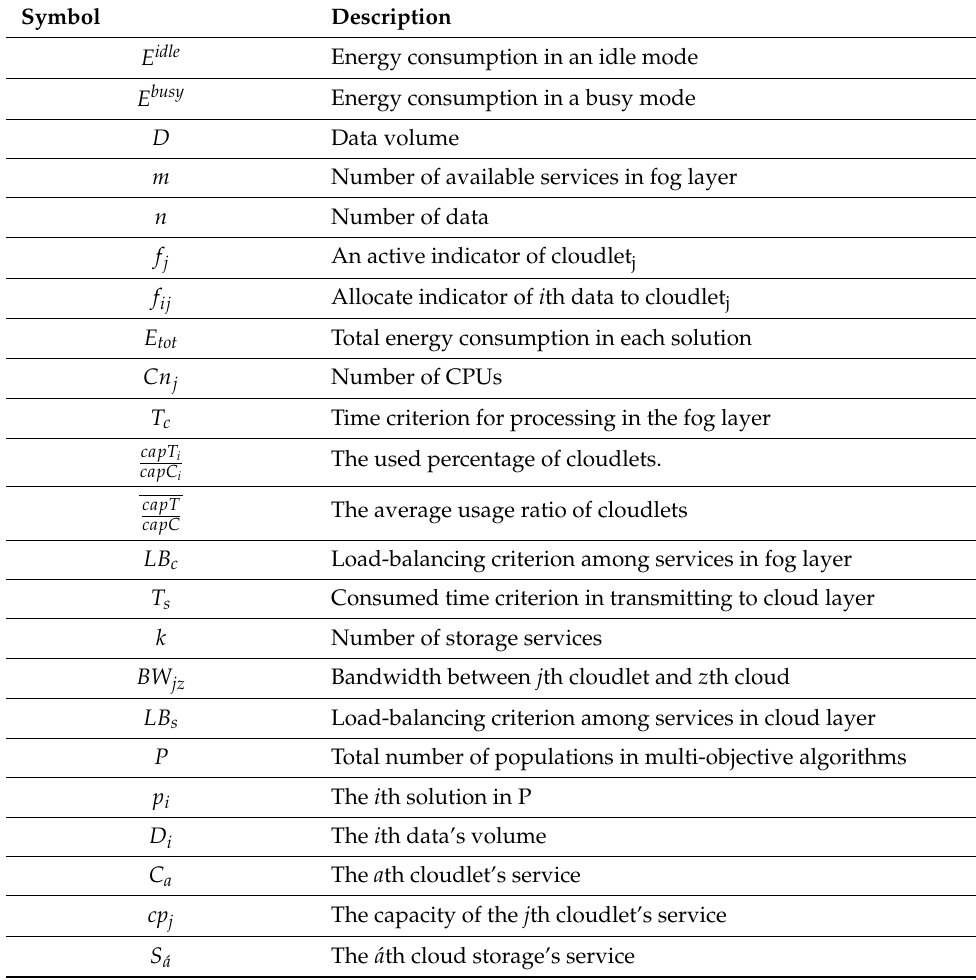
Table 2. Symbols and notations of objects’